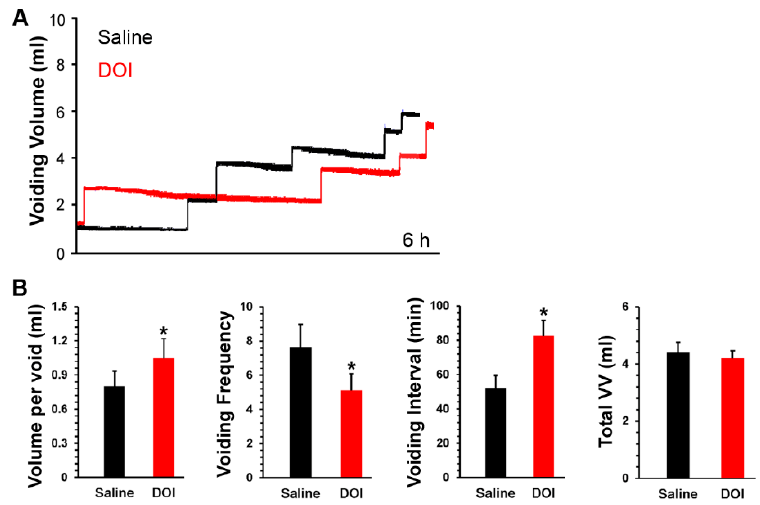
Figure 5. Stimulating 5-HT 2A receptors with DOI delivery improves spontaneous micturition function in SCI rats. Representative traces show volume-frequency patterns of urination in metabolic cage assays after 5-HT 2A receptor stimulation with DOI within a 6-h time period. Saline injections served as a control. In each “step-like” curve of these traces ( A ), the vertical lines represent the VV per void and the horizontal lines illustrate the VI. After s.c. injection of the 5-HT 2A receptor agonist DOI (60 µ g/kg, 300 µ L), ( B ) there was a significant increase in the VV per void and VI in comparison to saline controls (Paired t ‐ test, all * p < 0.05).